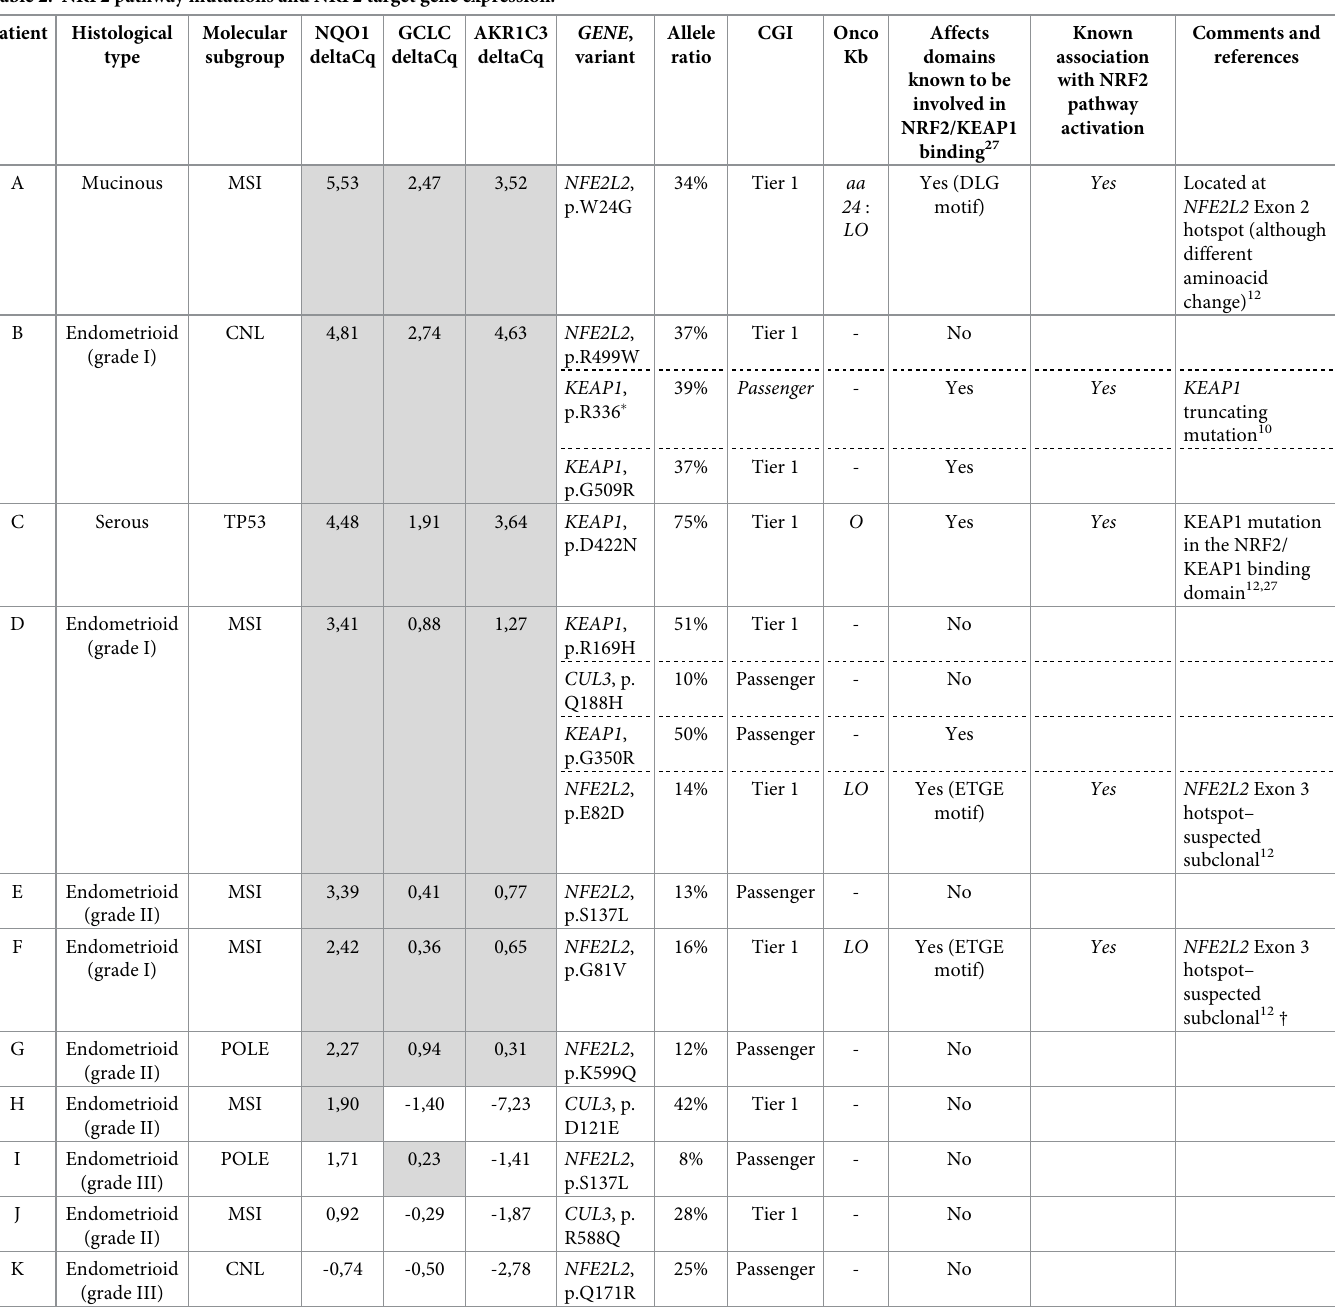
Table 2. NRF2 pathway mutations and NRF2 target gene expression. Patient Histological